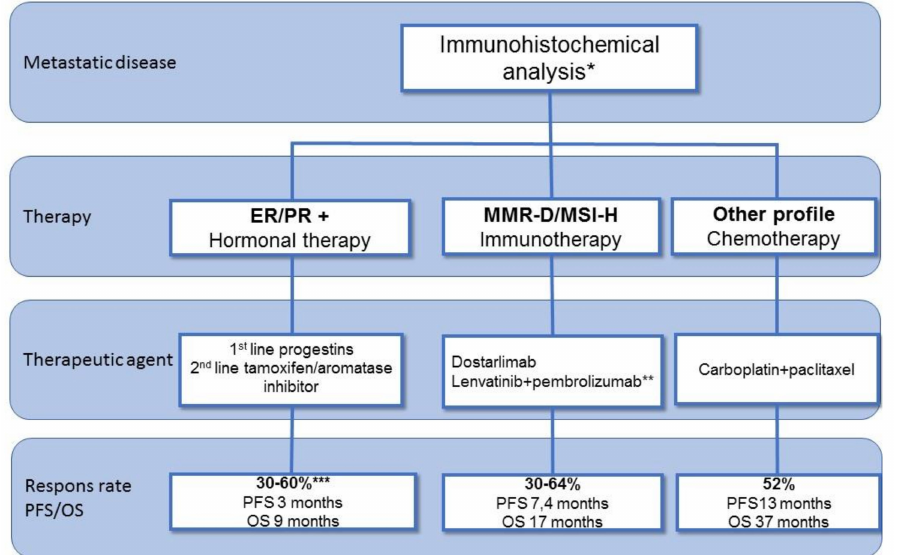
Figure 3. Overview of systemic treatment options in recurrent endometrial cancer. ER: estrogen receptor; PR: progesterone receptor; MMR-D: mismatch repair deficient; MSI: microsatellite instability; MSS: microsatellite stable; pMMR: proficient mismatch repair; PFS: progression-free survival; OS: overall survival. * Preferably histology on recurrent tumor ** also approved for pMMR/MSS